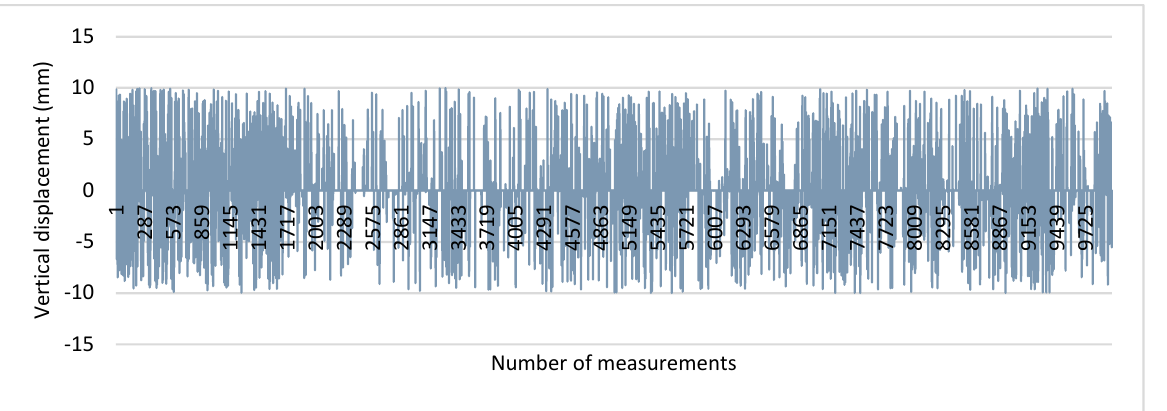
Figure 7. Results of a vertical displacement measurement with LDV Polytec PDV 100 for a passenger train in motion.